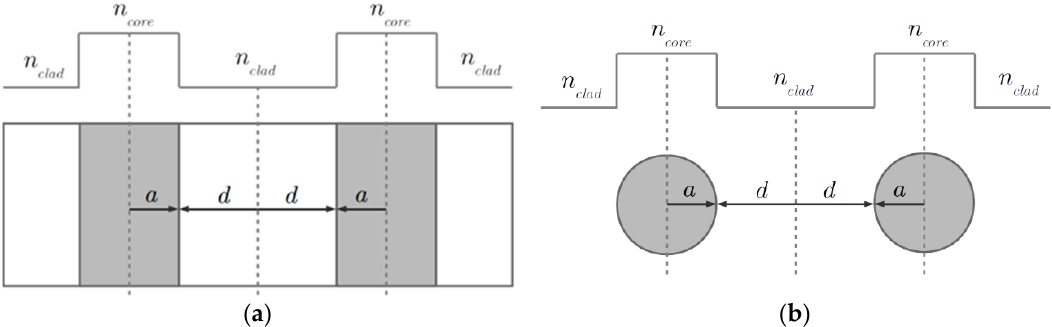
Figure 1. ( a ) Schematic of two coupled slab waveguides. ( b ) Schematic of two coupled circular cylindrical waveguides.